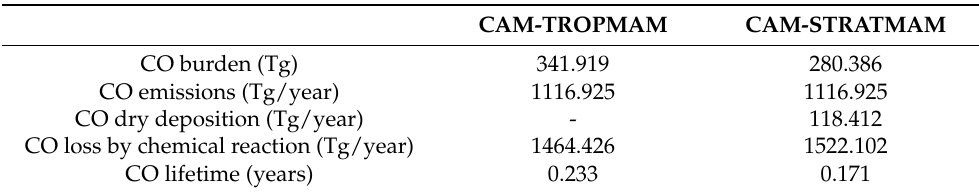
Table 1. Global balance of CO in the two configurations of the model: tropospheric chemistry only (CAM-TROPMAM) and tropospheric and stratospheric chemistry